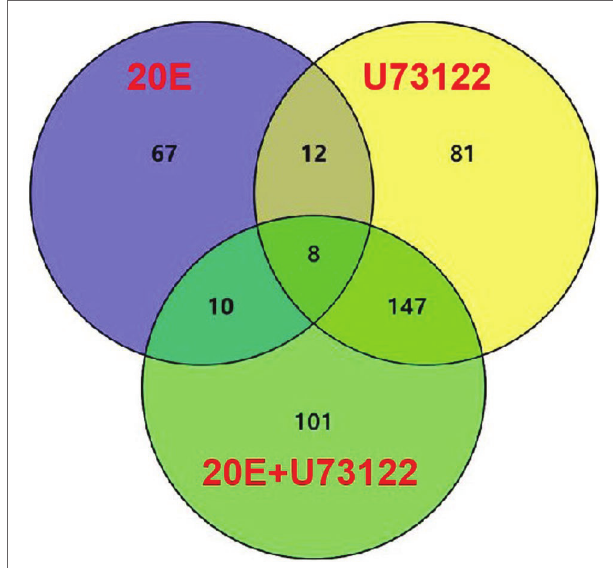
FIGURE 1 | Differentially expressed proteins (DEPs) with a change ≥ 2.0-fold in Apolygus lucorum after treatment with 20E, U73122, and 20E + U73122, respectively. Coregulated DEPs between two time points are also